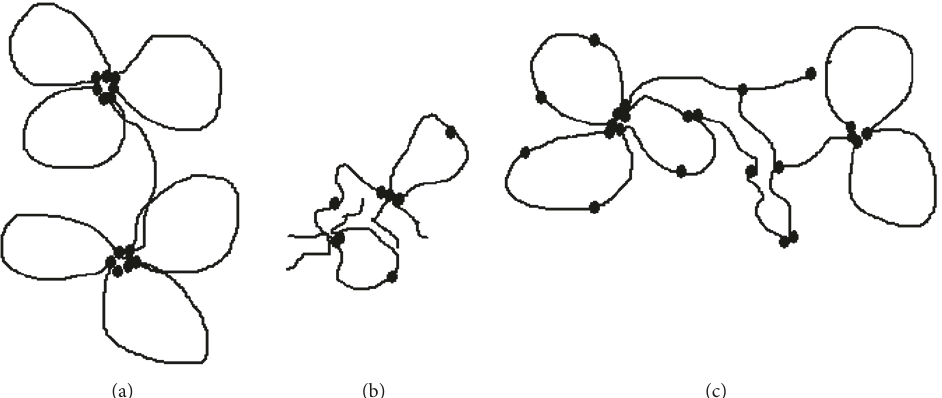
Figure 12: Schematic representation of the hydrophobic associations for the copolymers synthesized: (a) telechelic, (b) multisticker, and (c) combined.